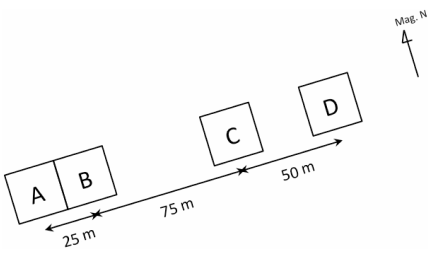
Figure 1. Diagram describing the distribution of the antenna sets used for the interferometric observations. Each antenna set is formed by a four by four array of Yagi antennas. A, B, C and D represent the antenna sets. Transmissions are made with sets A and B. Reception is made with all of the antenna sets. The magnetic declination is approximately 21 ◦